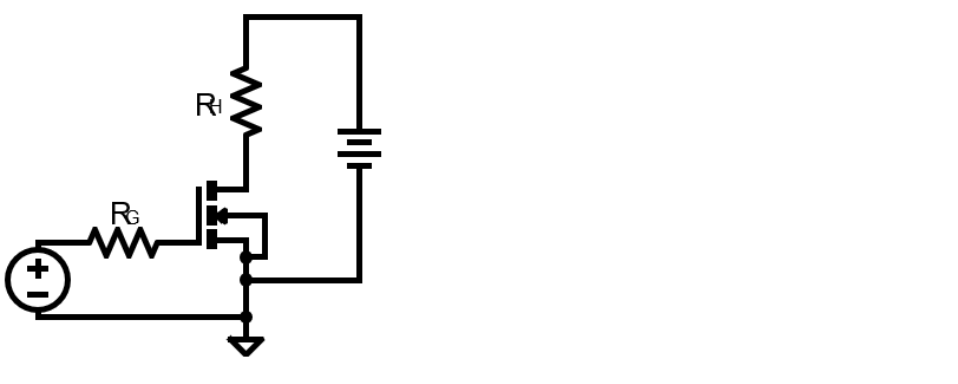
Figure 20. Heating control circuit, with a power resistor controlled by PWM modulation and a gate resistor.